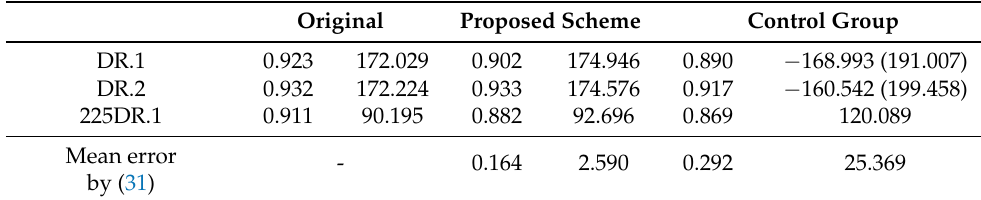
Table 3. Quality evaluation of DR.1–DR.2 and 225DR.1 in the CQP SAR data set without additionally additive noise. The unit of measure in the second row, the fourth row, and the fifth row is dBs, and the unit of measure in the third row is degrees ( ◦ ). For obvious comparison, the values in brackets in the seventh column are in phase periods of 0 to 360 degrees. The last row shows the errors of the results of the proposed method and the control group compared to the corner reflectors by (31).